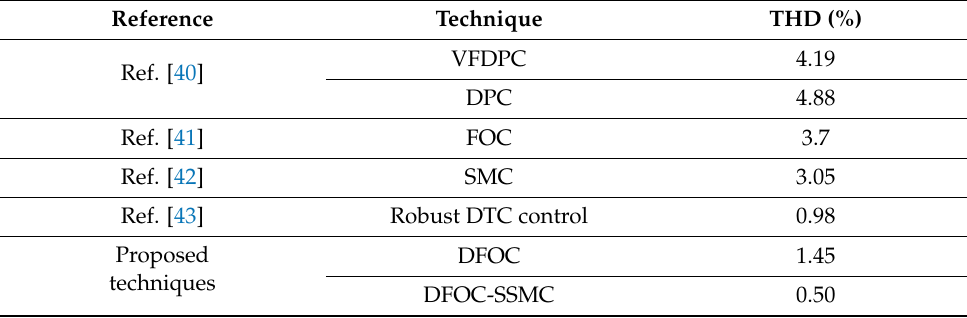
Figure 14. THD (direct FOC-SSMC control).